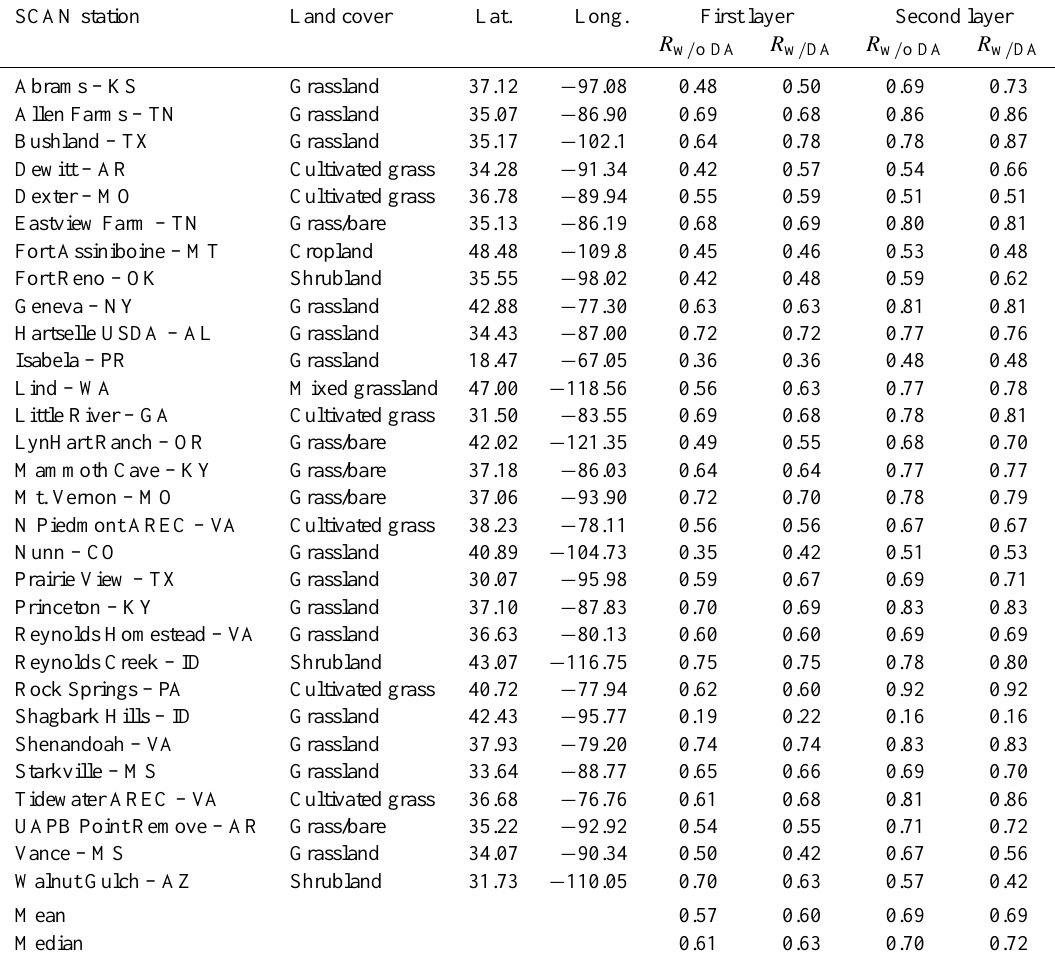
Table 2. SCAN study sites and results of the validation of the modelled soil moisture profile. SCAN